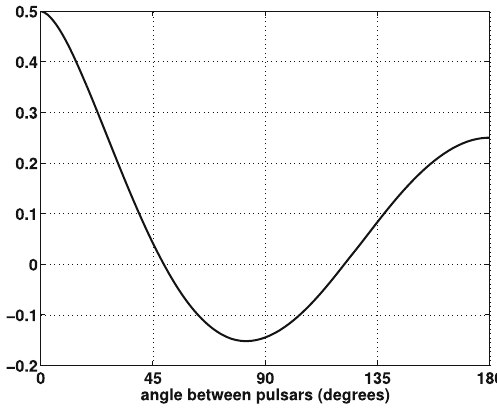
Fig. 37 Plot of the Hellings and Downs curve as a function of the angular separation between two distinct